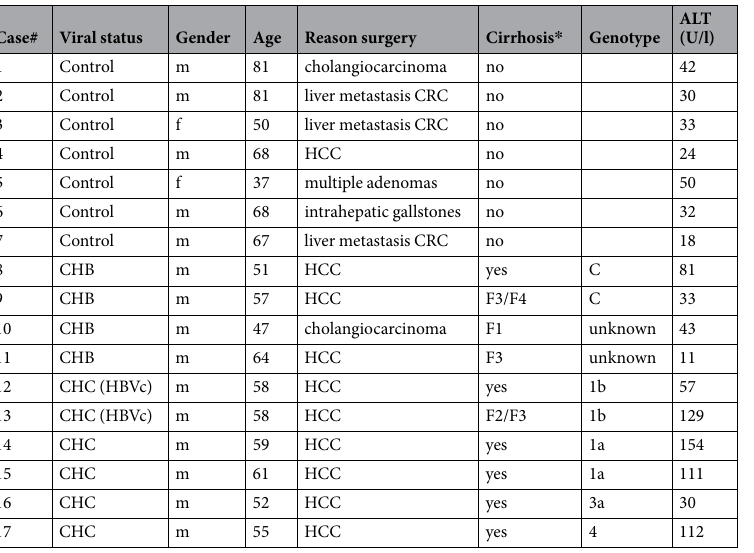
Table 1. Patient characteristics. * Cirrhosis based on METAVIR score at histology. Abbreviations; ALT, alanine aminotransferase; m, male; f, female; CRC, colorectal carcinoma; HCC, hepatocellular carcinoma; CHB, chronic hepatitis B; CHC, chronic hepatitis C; HBVc, cleared acute hepatitis B